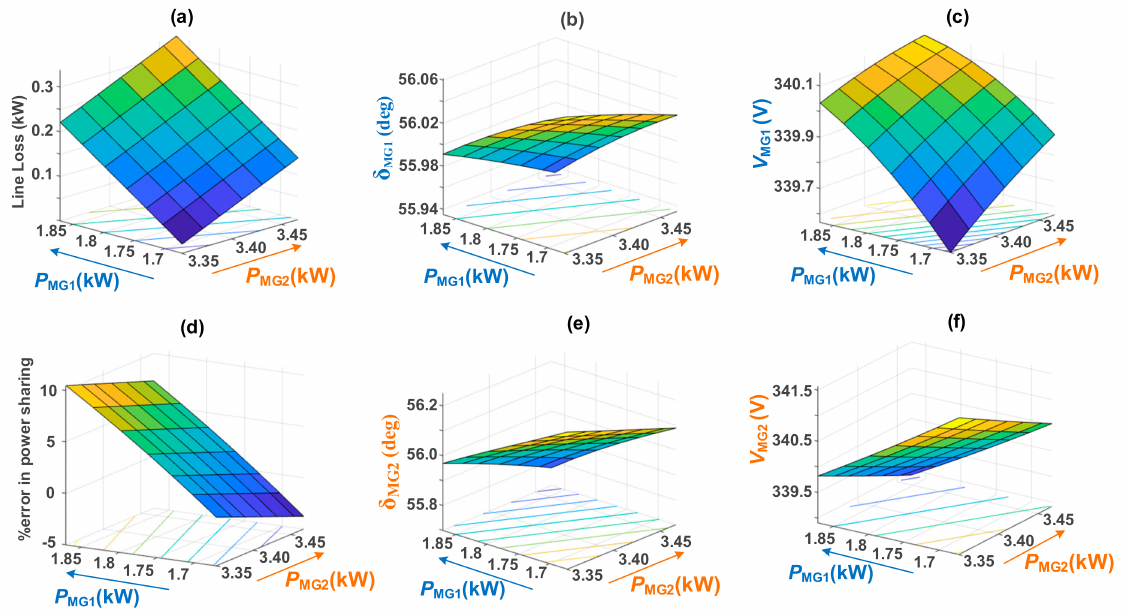
Figure 21. Sensitivity analysis with variation of power from HMGs due to increase in line resistance: ( a ) line loss ( b ) droop angle MG-1 ( c ) droop voltage MG-1 ( d ) error in power-sharing ( e ) droop angle MG-2 ( f ) droop voltage MG-2.